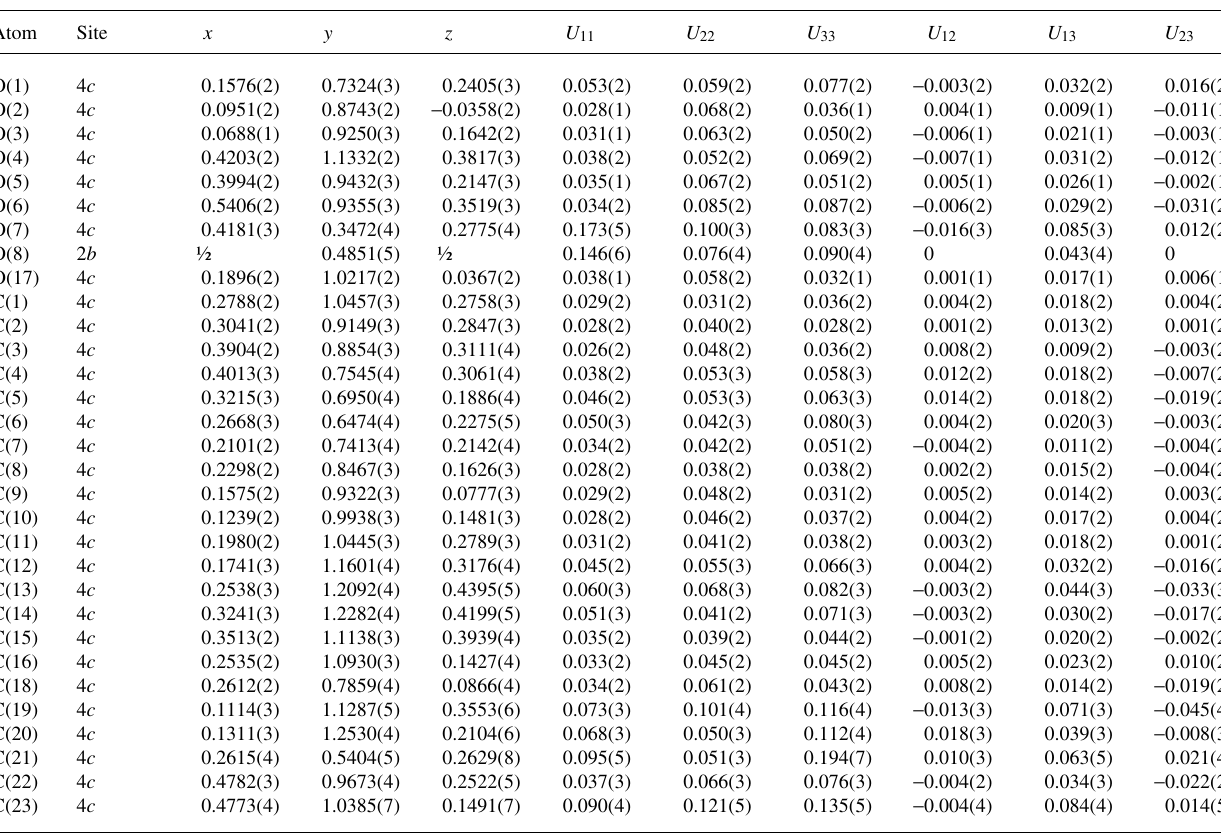
Table 3. Atomic coordinates and displacement parameters (in Å 2 )